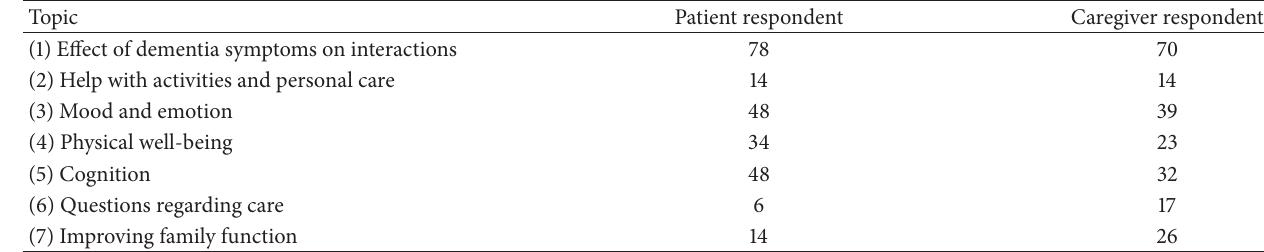
Table 3: Percent of family focused responses by question ( 𝑛 = 77